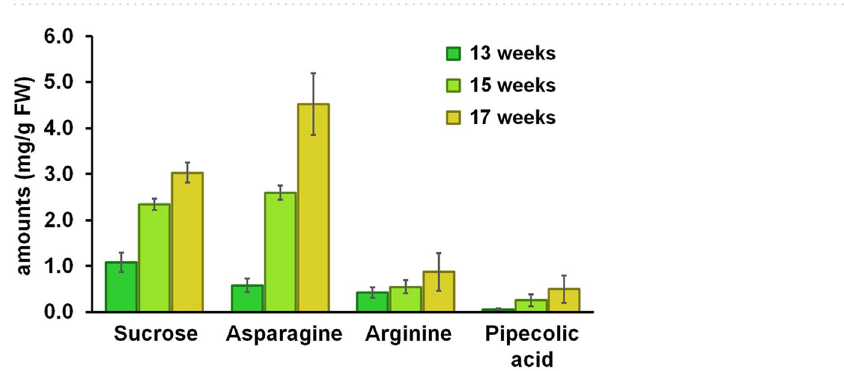
Figure 5. ( A ) MS spectrum of the liquid extract (15 weeks) obtained from LC–MS/MS (QTOF); ( B ) the chemical structures of identified compounds; ( C ) 1 H NMR (D 2 O, 500 MHz) spectrum of partially purified liquid extract with peaks associated with asparagine in blue boxes, and those with pipecolic acid in green boxes.